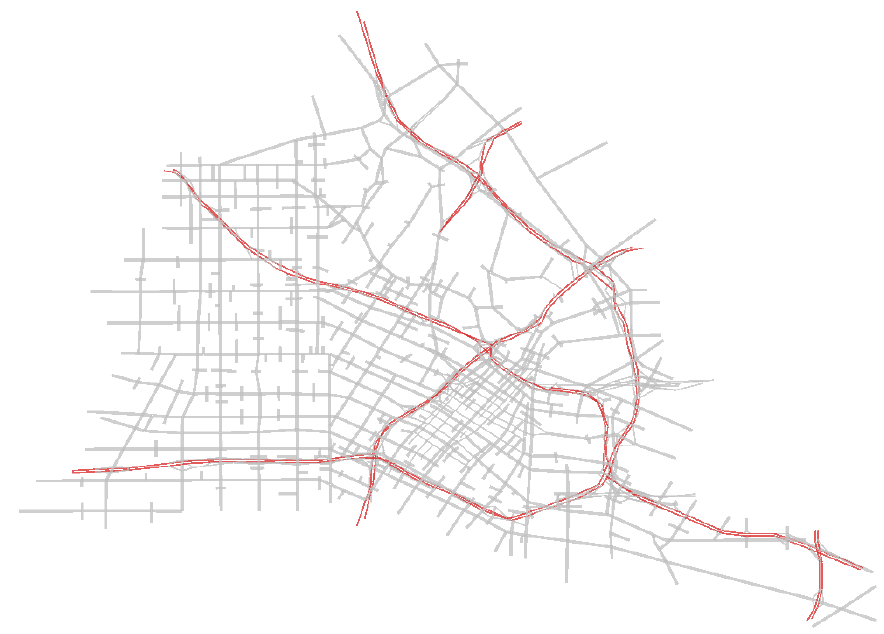
Figure 9. Downtown LA network